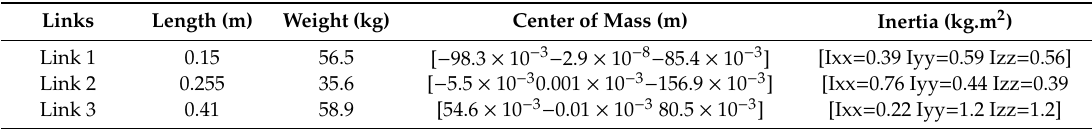
Table 1. Parameters of 3-DOF robot manipulator in Matlab